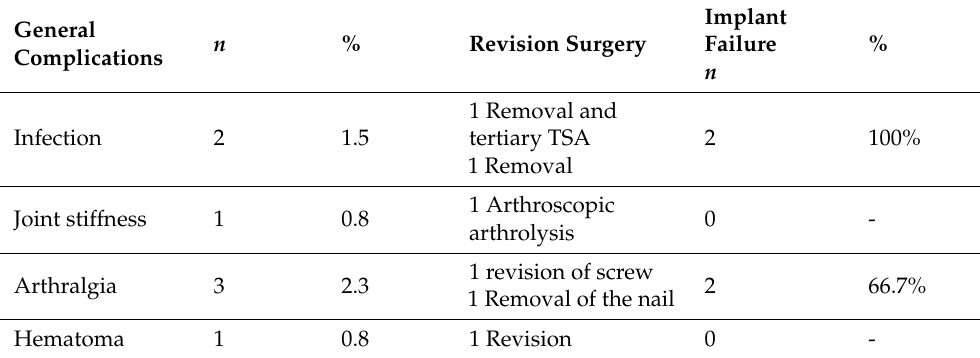
Table 3. General complications, revision surgeries, and implant failures; TSA = total shoulder